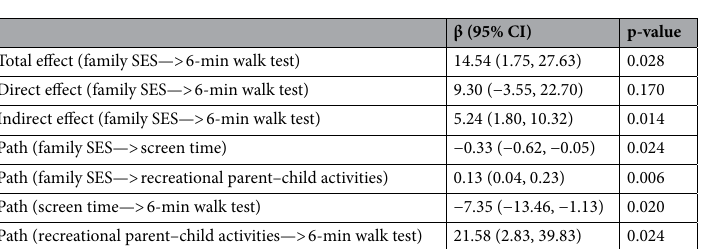
Table 4. Path estimates for the model linking family SES at Wave 1 and 6-min walk test performance test performance at Wave 3. Adjusted for child age, gender, and history of physical diseases.